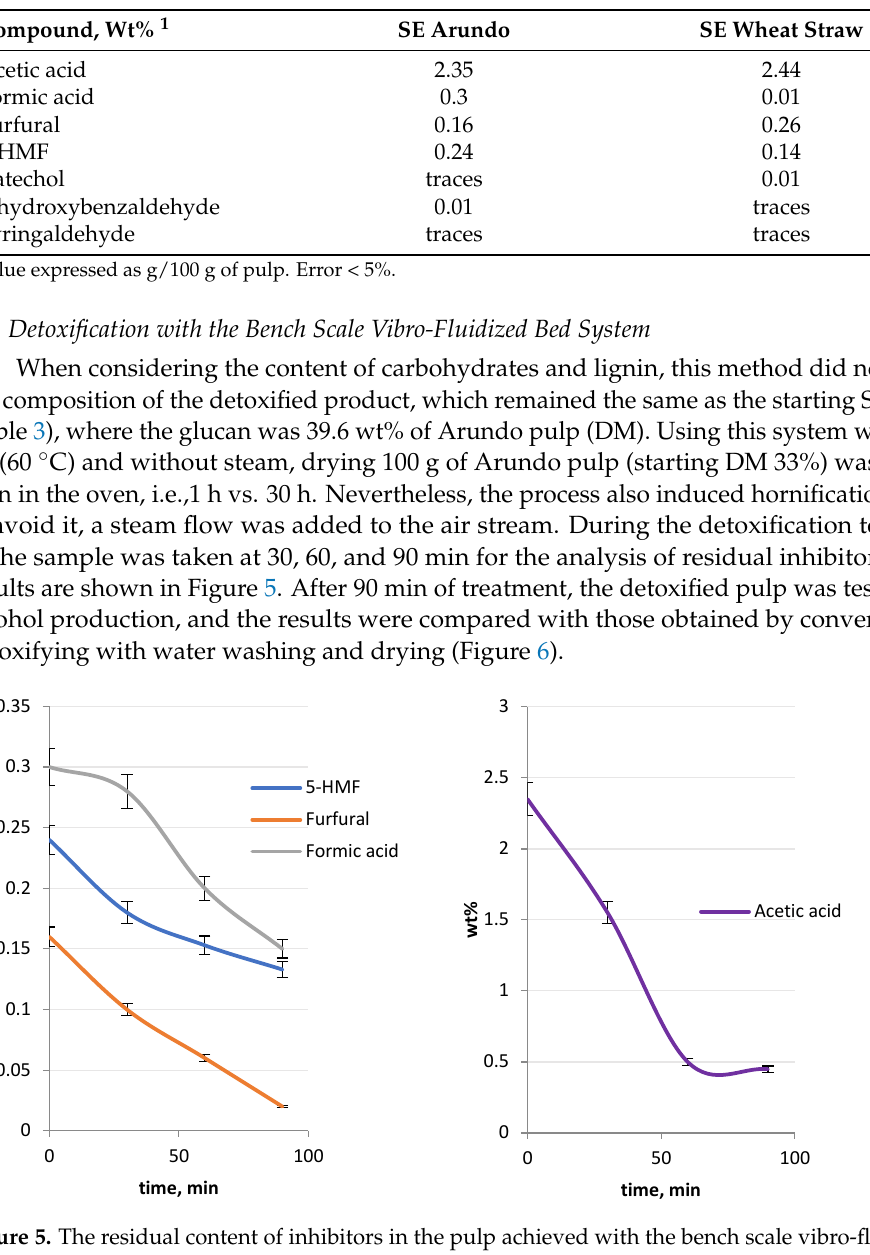
Table 4. Inhibitors detected in the steam-exploded biomass.